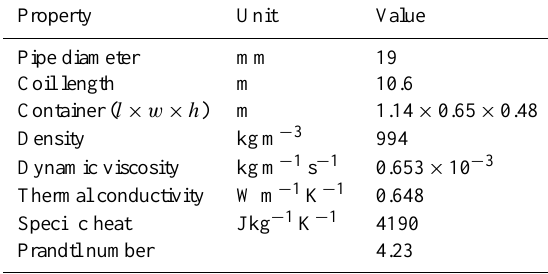
Table 1. Thermal properties and system dimensions.